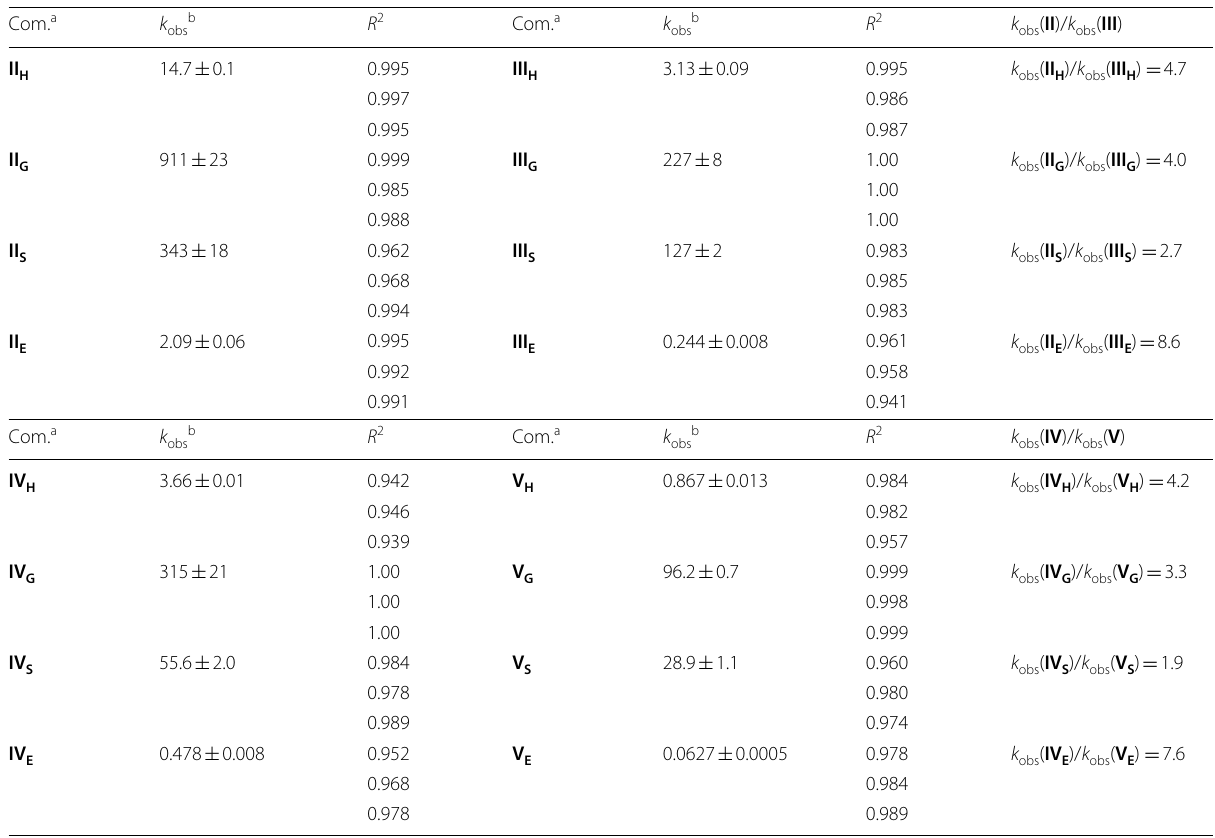
Table 1 Pseudo-first-order reaction rate constants ( k ) obtained from three duplicated runs and squared correlation coefficients ( R 2 ) obs of each run in the MnO oxidation of compounds IV and V observed in this study and in that of compounds II and III observed in our 2 recent report